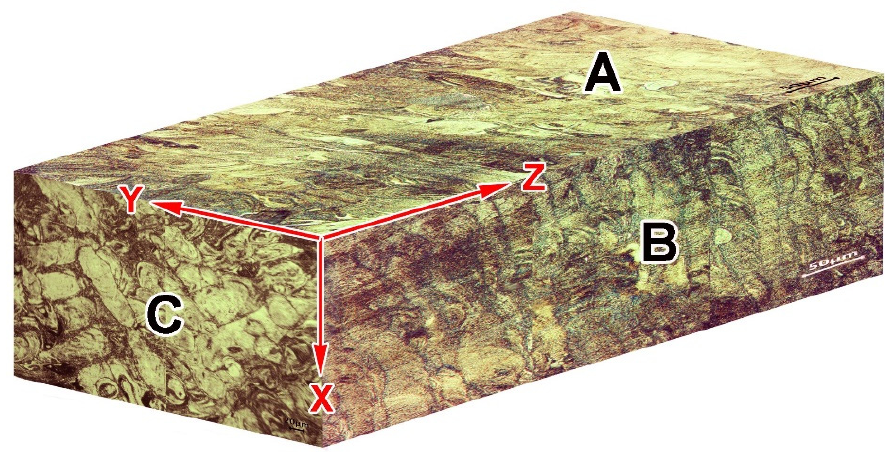
Figure 3. Microstructure distribution in the LPBF-printed specimen (Z is the axis of layering during printing).